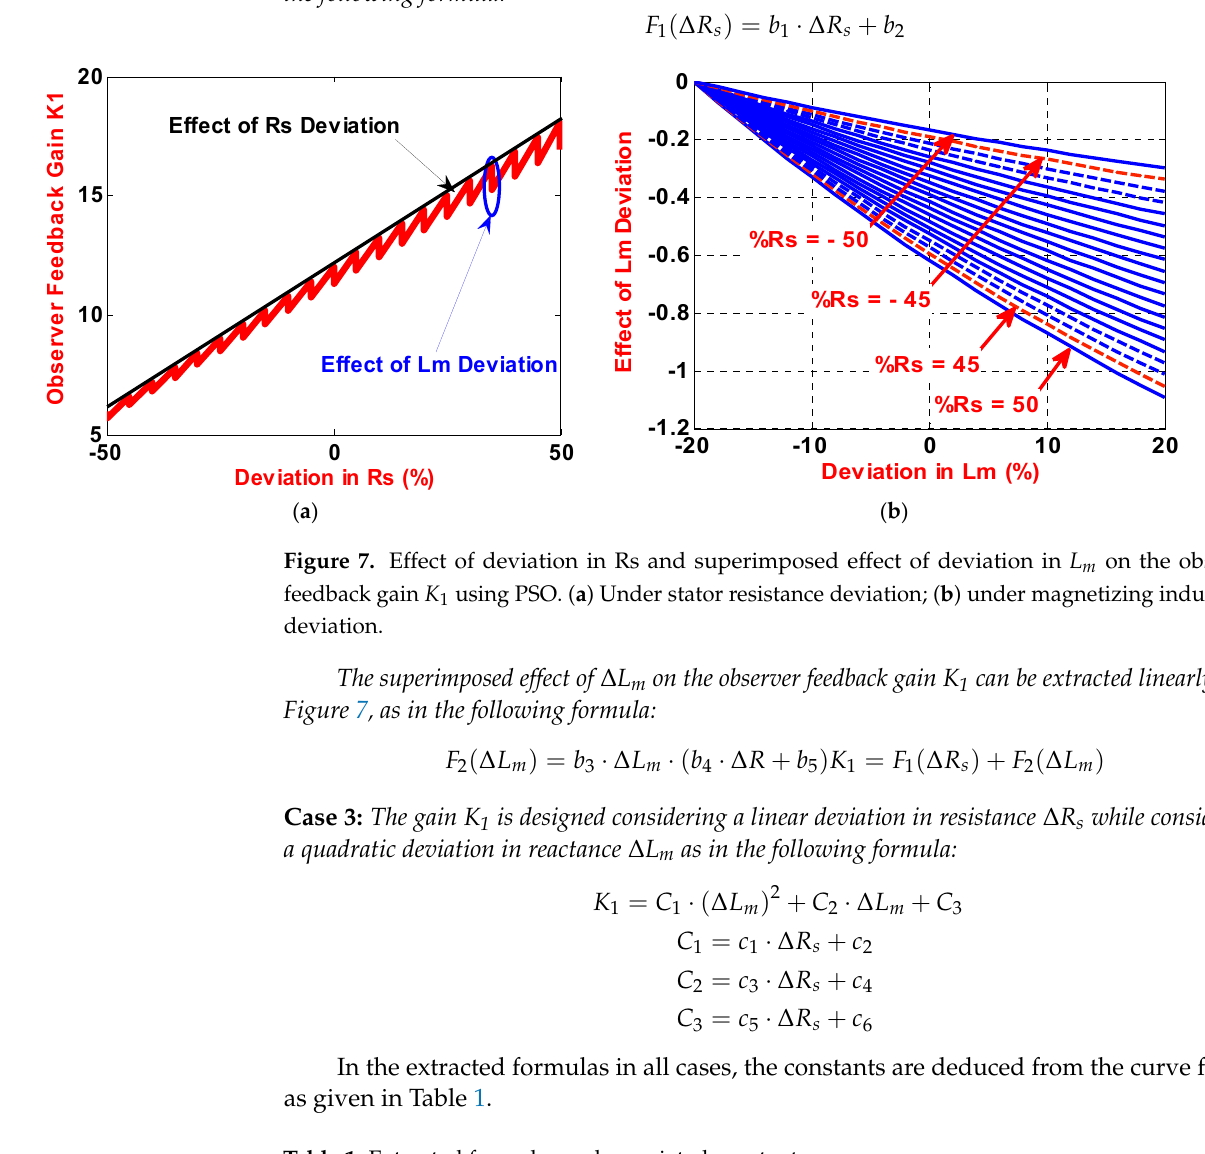
Table 1. Extracted formulas and associated constants.